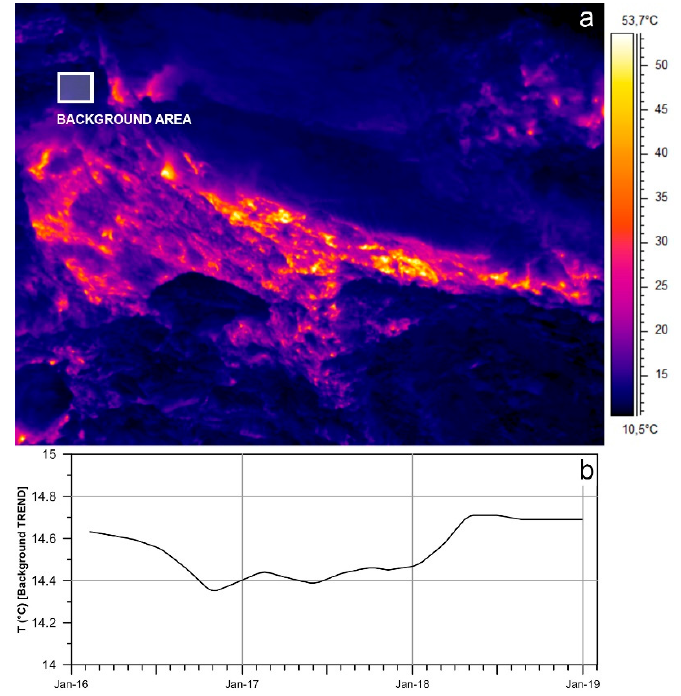
Figure 9. Background area boundaries inside the SF1 IR frame ( a ) and plot of Trend component of background area which is obtained by applying STLd method ( b ). Trend values varie between 14.35 and 14.7 °C.